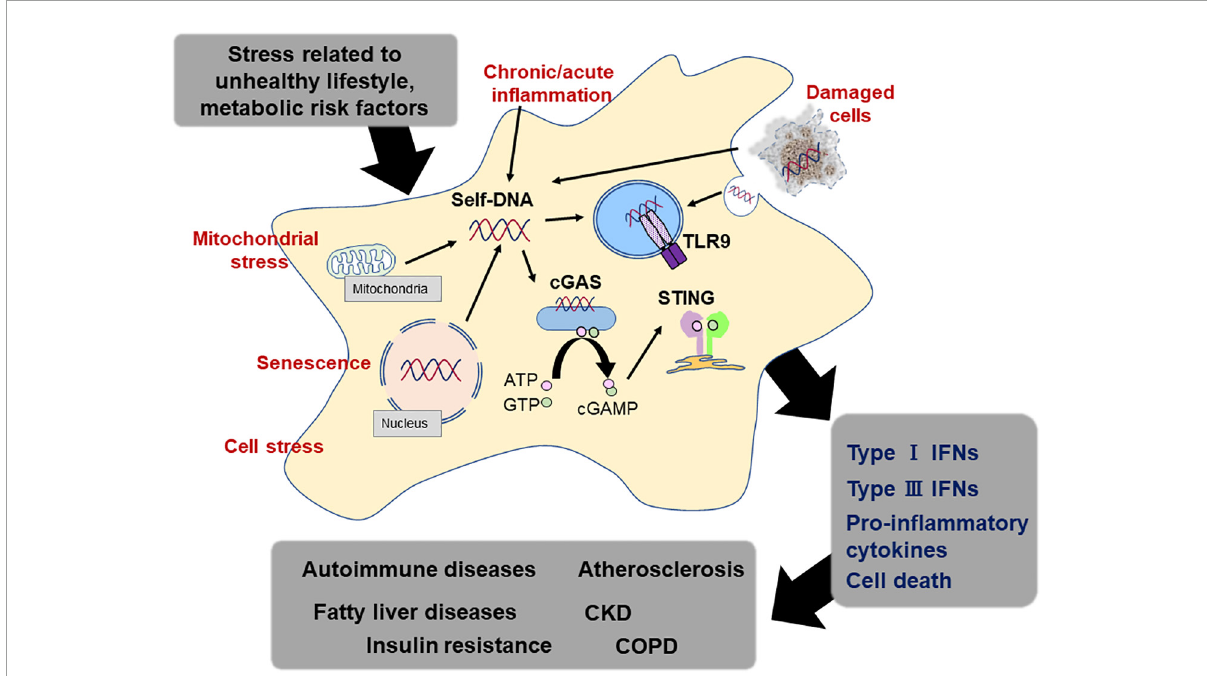
FIGURE3 DNA sensing system and lifestyle-related diseases. Endogenous DNA fragments activate the DNA sensing mechanism, which participates in the activation of the immune response. Immune response caused by endogenous DNA fragments via DNA sensors such as TLR9 and STING accelerates sterile inflammation, leading to the development of lifestyle-related diseases, such as atherosclerosis, metabolic diseases, and pulmonary